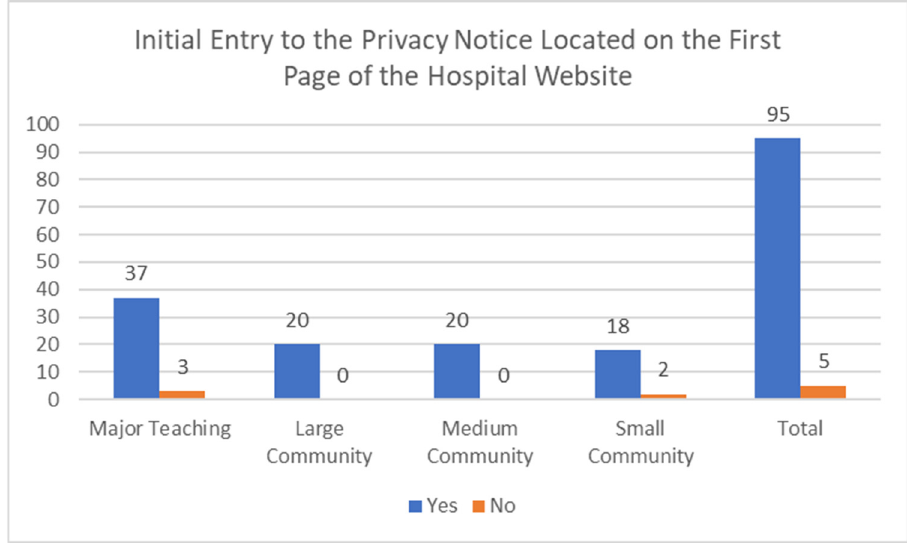
Figure 3. Initial Entry to the Privacy